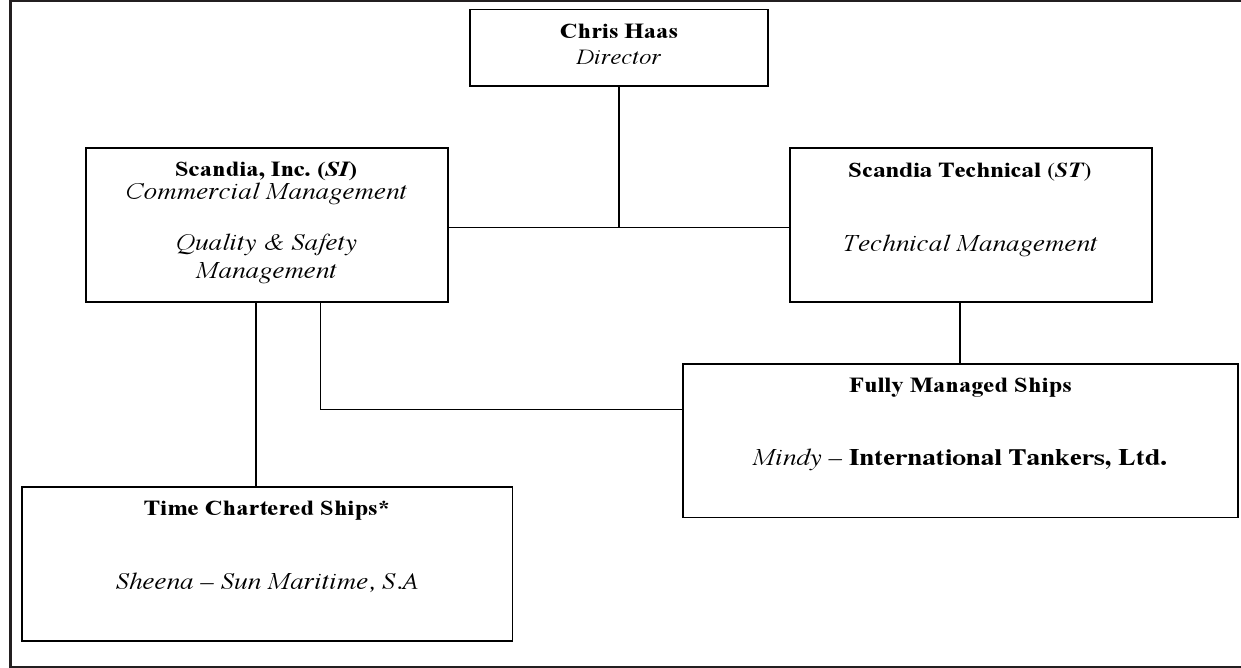
Figure 2. Basic Relationship between Companies and